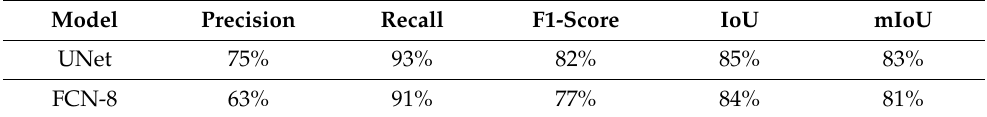
Table 2. Evaluation of the results.